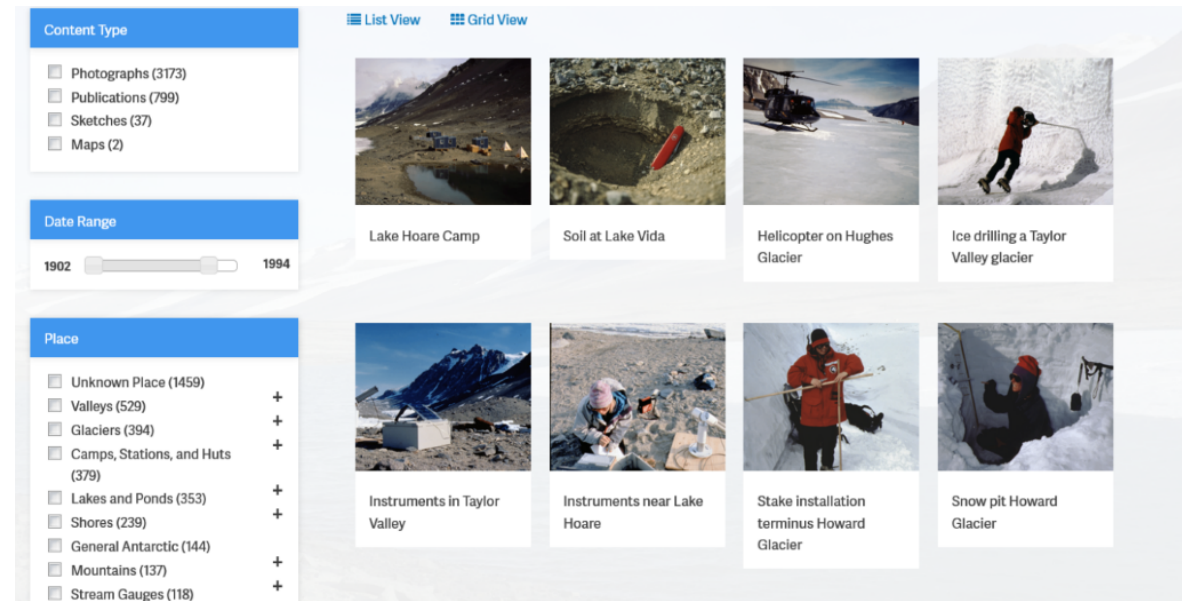
Figure 3. Browser-based interface for searching the archive. The window on the right-hand side refreshes as the filters on the left-hand side are applied. Clicking on a photo or other piece of content opens a new window showing a larger image and the associated metadata.